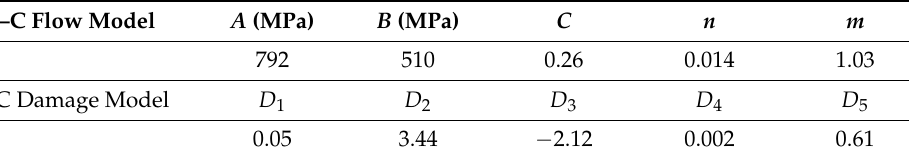
Table 2. Johnson–Cook’s flow and damage